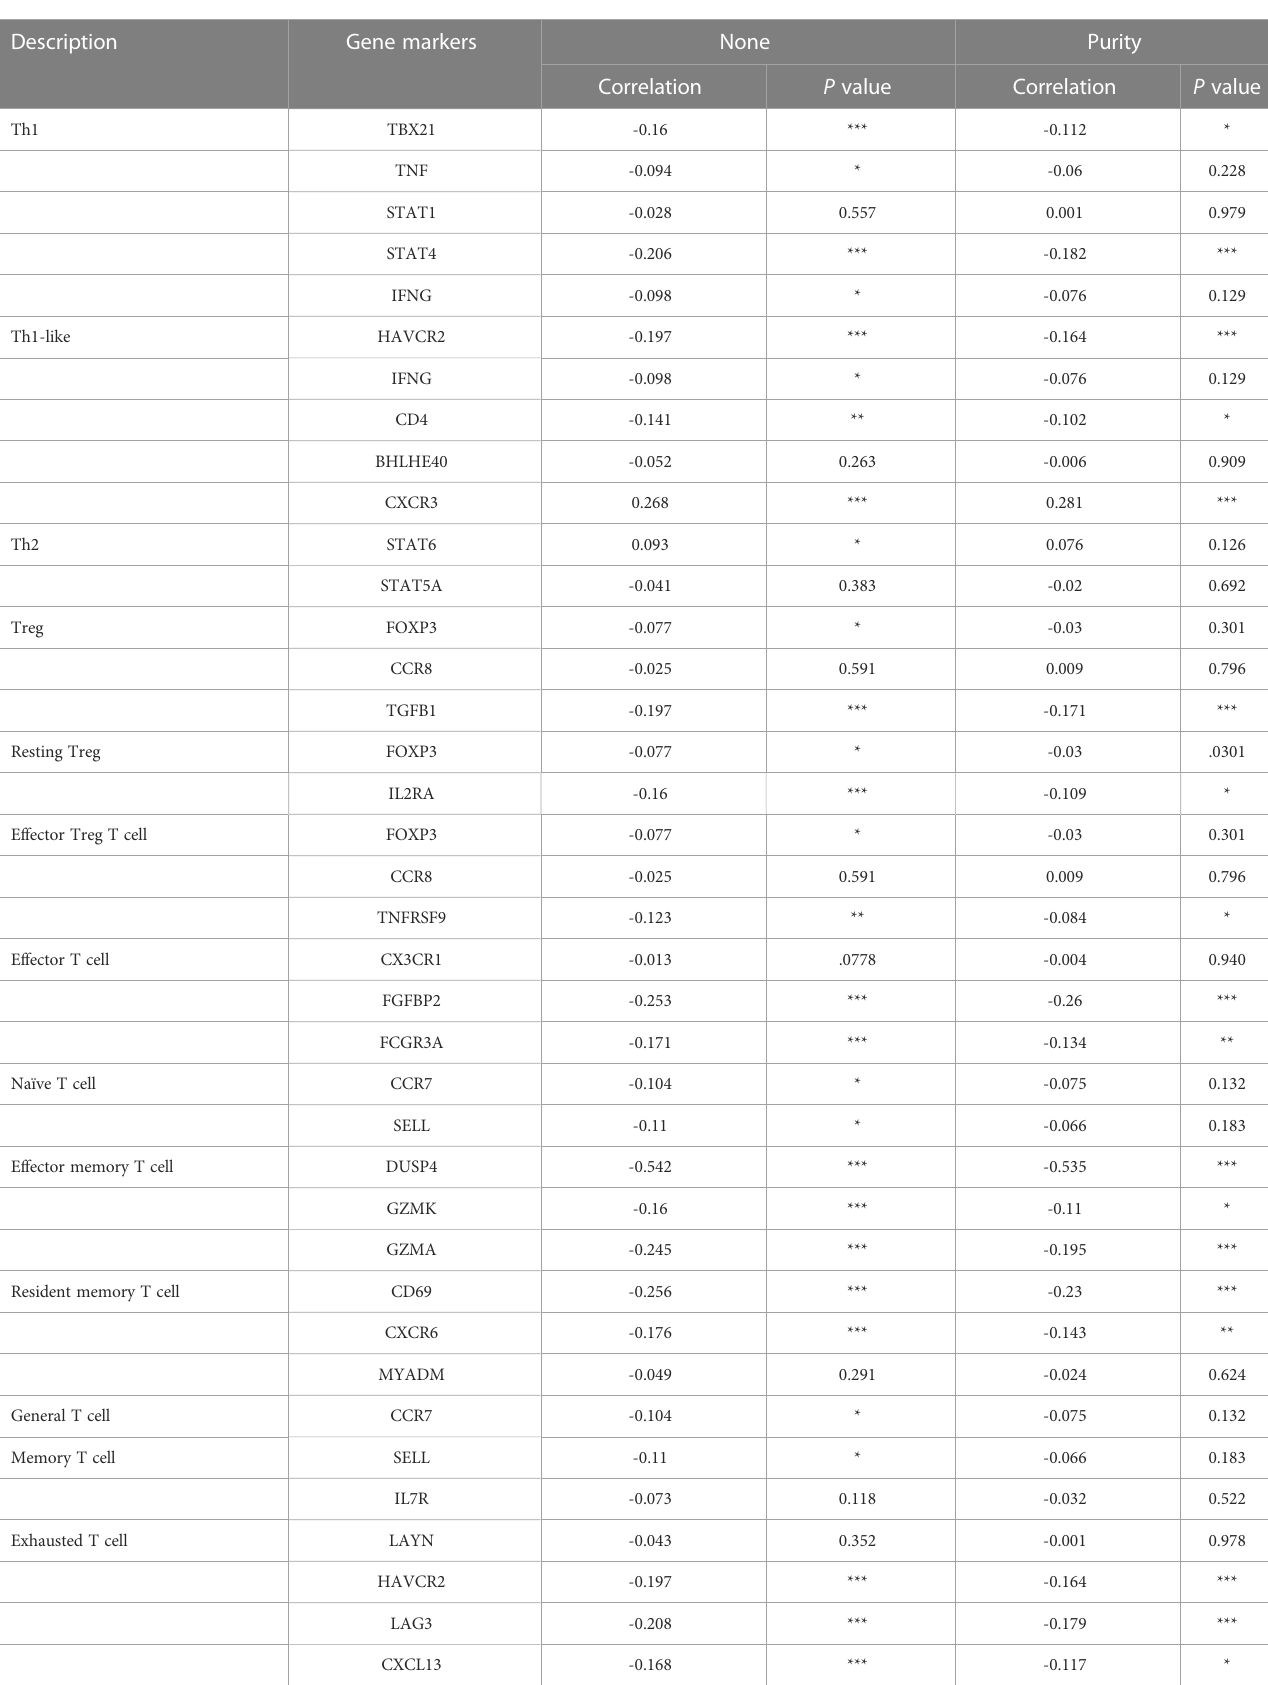
TABLE 2 Correlation analysis between TOMM34 and gene markers of distinct types of T cells in